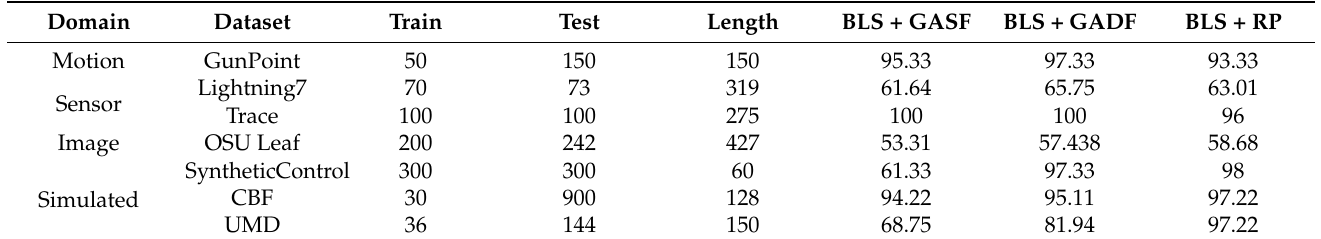
Table 1. The classification accuracy of images from different datasets using the BLS